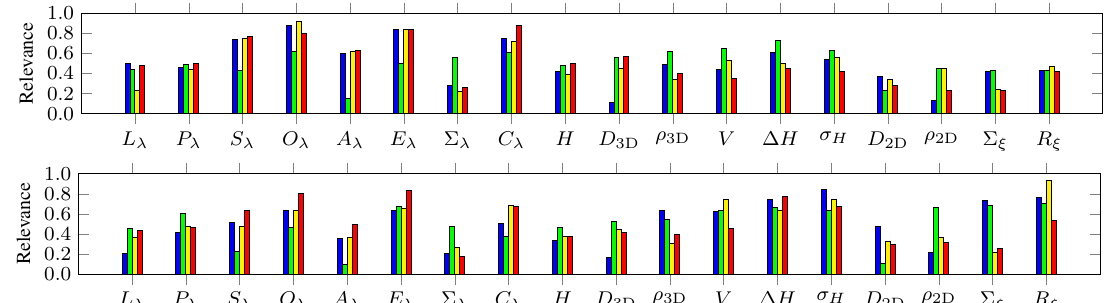
Figure 6. Feature relevance for Oakland-3C (top) and Oakland-5C (bottom) when using the reduced version of the original training data ( 1 , 000 examples per class) and the neighborhood types N s, 1m (blue), N c, 1m (green), N k =50 (yellow) and N k